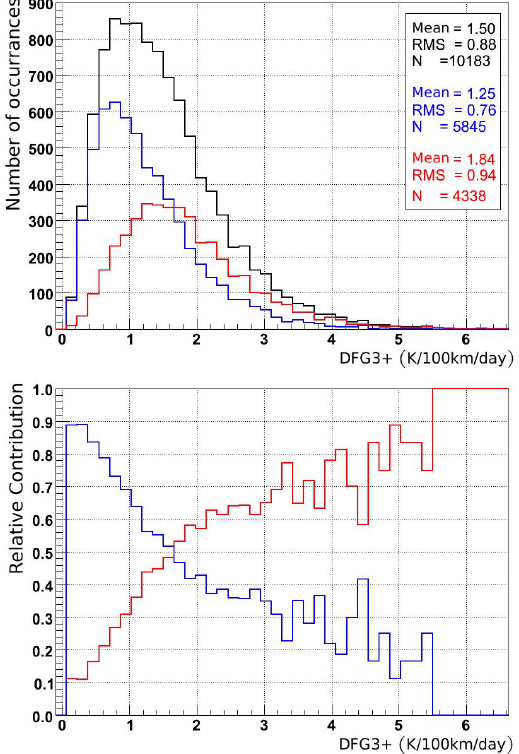
Fig. 6. Top: Histograms showing the distribution of DFG3+ for: all the time instants (black), only those when the AC was detected (red), and only those when the AC was not detected (blue). Lower: the relative contribution of the cases with (red) and without AC (blue).